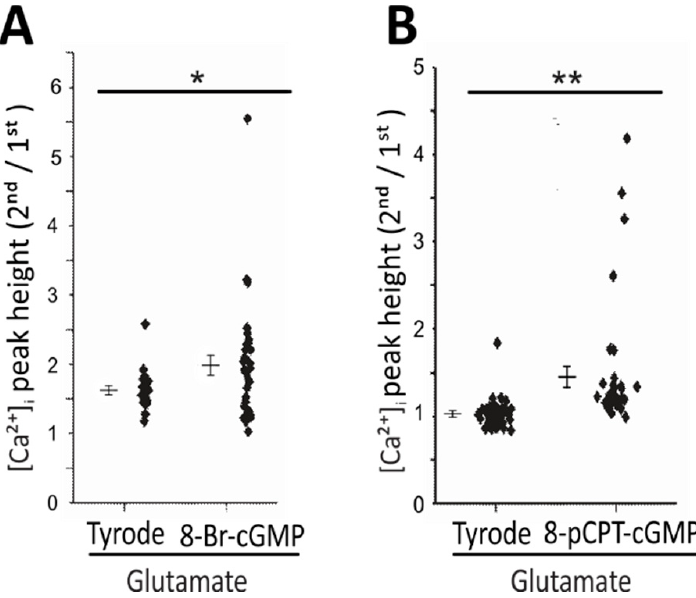
Figure 3. The addition of cGMP analogues confirmed cGMP–Ca 2+ crosstalk in CGNs. ( A ) Quantification of glutamate (100 µM, 10 s)-induced elevation of [Ca 2+ ] i in the absence of cGMP